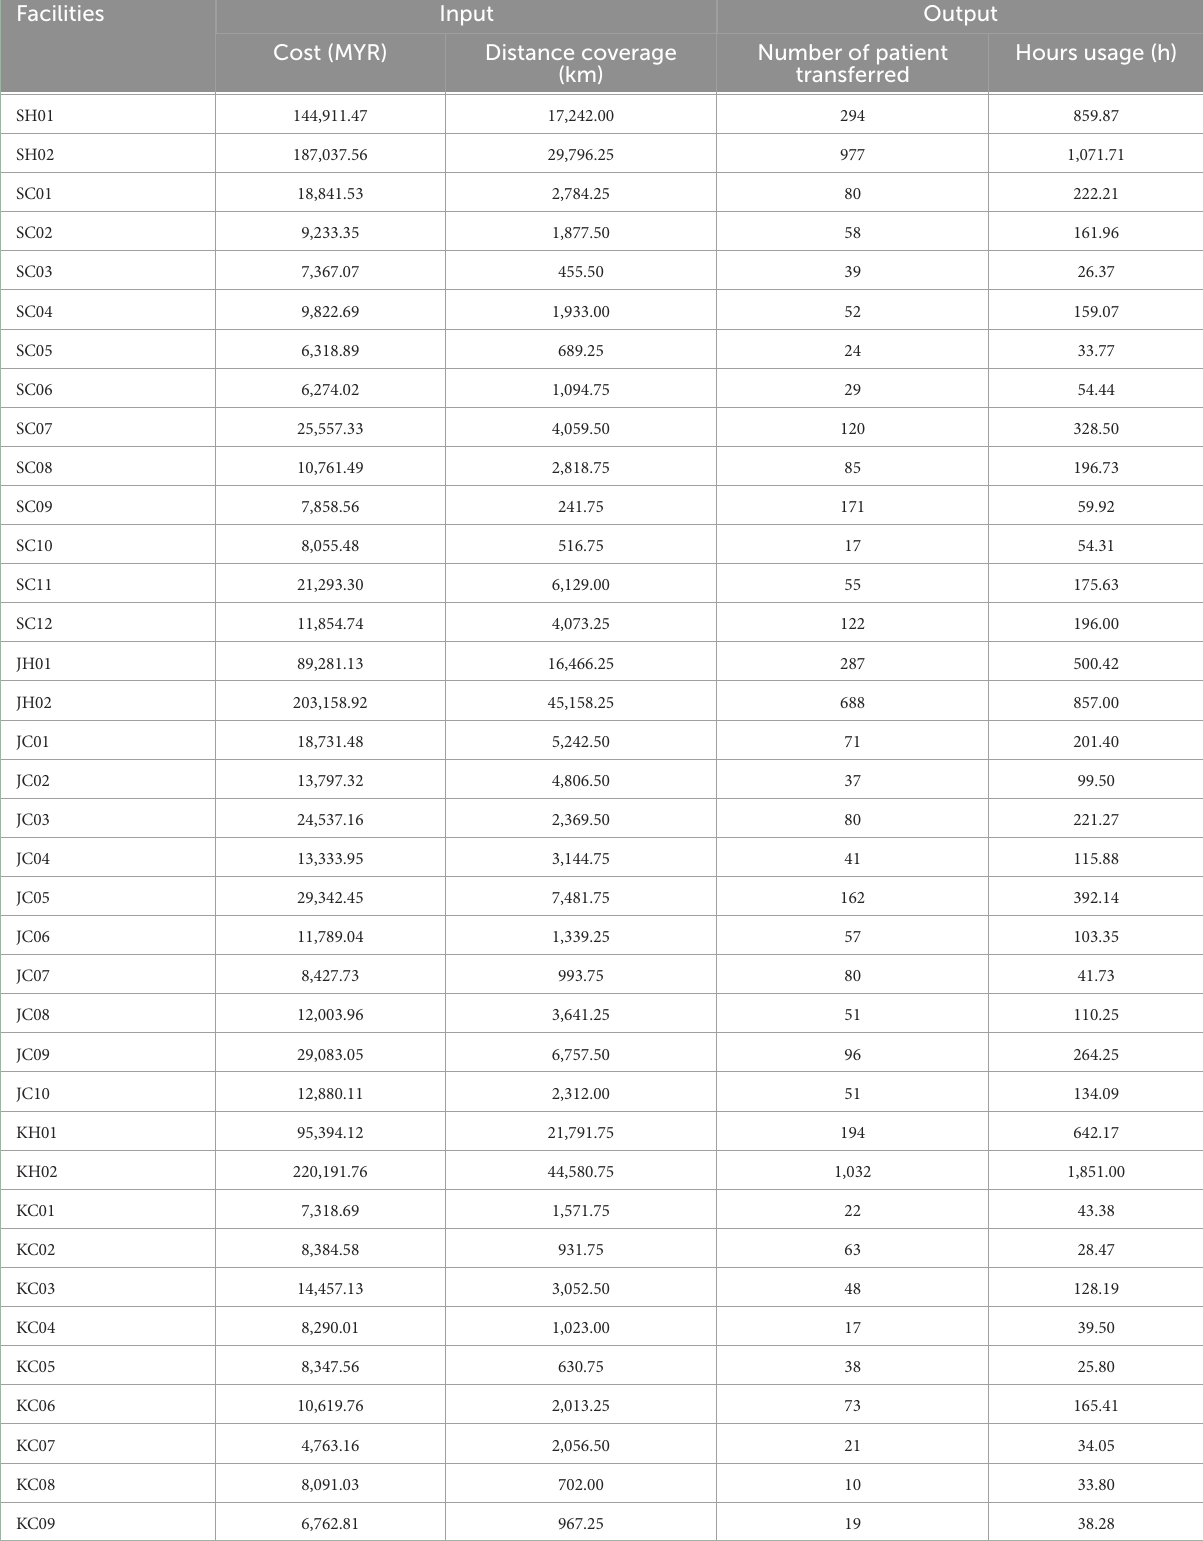
TABLE 1 Descriptive statistics of input and output